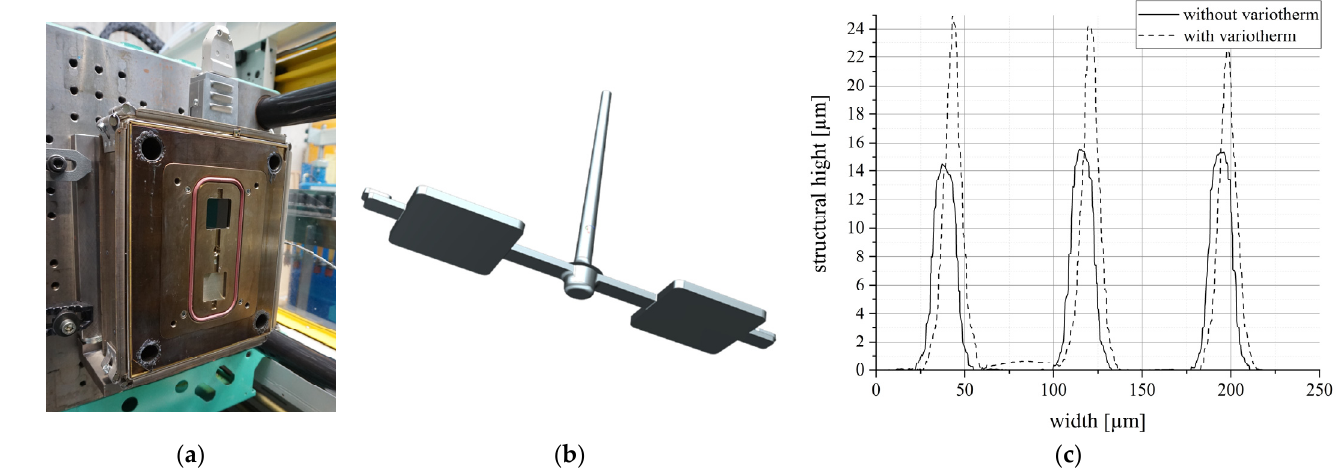
Figure 4. Molding process. ( a ) Injection mold with structured inserts and frame heating, ( b ) demonstrator component with two structured plates (40 × 40 mm) and bar casting and ( c ) influence of variothermal temperature control on impression quality of grooves with critical process parameters.